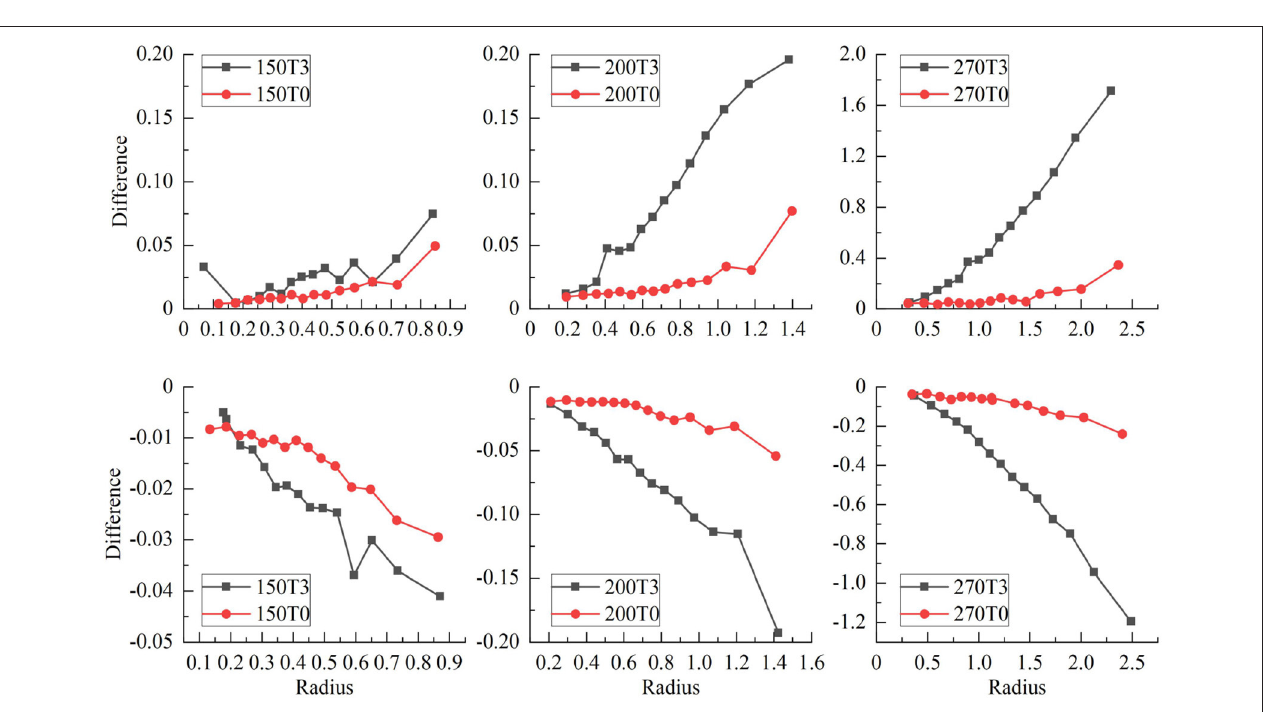
circles were obtained for each isodose curve to be plotted in Figure 7 . The area differences of these circles exhibited a certain regularity in the presence of the magnetic field. The average radius differences for a field strength of 3.0 Tesla were twice those without a magnetic